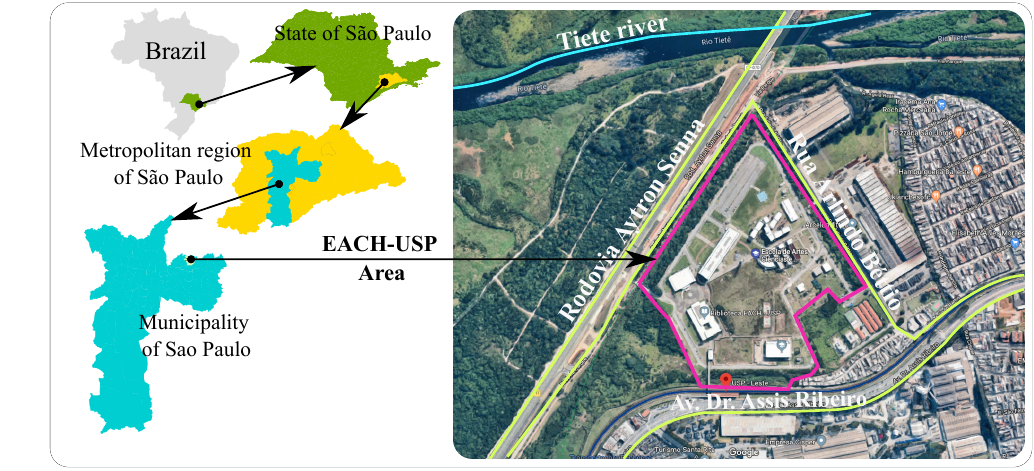
Figure 2. Location of the study area (Source: Adapted from Google